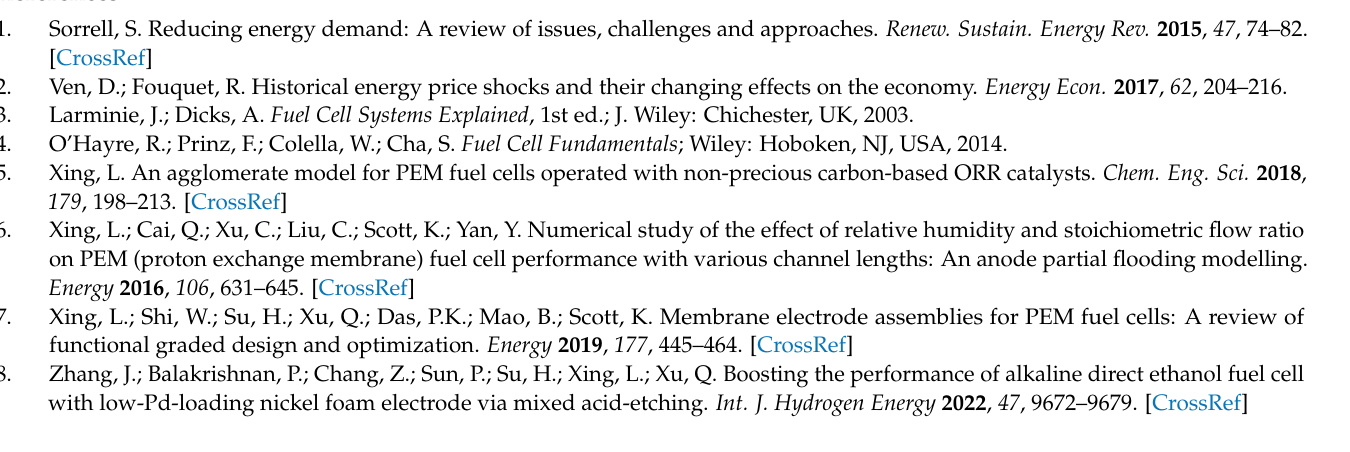
5 wt.% graphene MEAs at 1 M ethanol concentration; Figure S7: ( a ) Power density curve and ( b ) Temperature profile of standard and 5 wt.% graphene MEAs at 1 M 2-propanol concentration; Figure S8: Graphene dispersion preparation procedure; Figure S9: Membrane electrode assembly (MEA) preparation methodology; Figure S10: Single fuel cell set up used in the laboratory; Figure S11: ( a ). Schematic of electrode porosity measurement; ( b ) Lab-made set up; ( c ) Closer view of the electrode arrangement; Figure S12: Determination of ion-exchange capacity experiment - ( a ) Before and ( b ) After phenolphthalein addition; Table S1. Average values of elemental analysis results of graphene flakes by elemental dispersive spectroscopy (EDS); Table S2. Comparison of water-uptake (WU) and ion-exchange capacity values of different electrodes; Table S3. Open circuit voltage, and peak power density values of standard and different graphene wt.% MEAs; Table S4. Comparison of this work with recent literature. References [51–53] are cited in the Supplementary